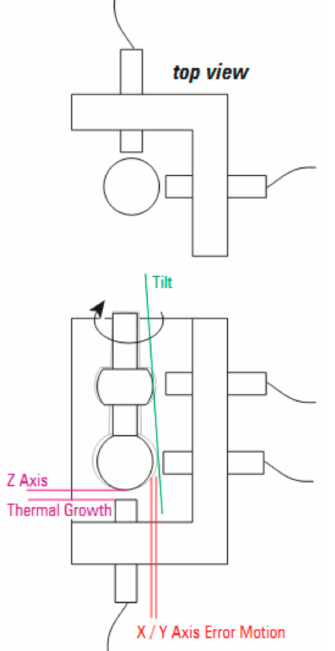
Figure 14. Set and arrangement of sensors (SEA) [22]. Depending on the type of machine and the tested rotational speed of the spindle, the set comes with several options (Table 1). Table 1. Configurations of holders for mounting capacitive sensors and calibration spheres adapted to cooperate with them. Sensor System